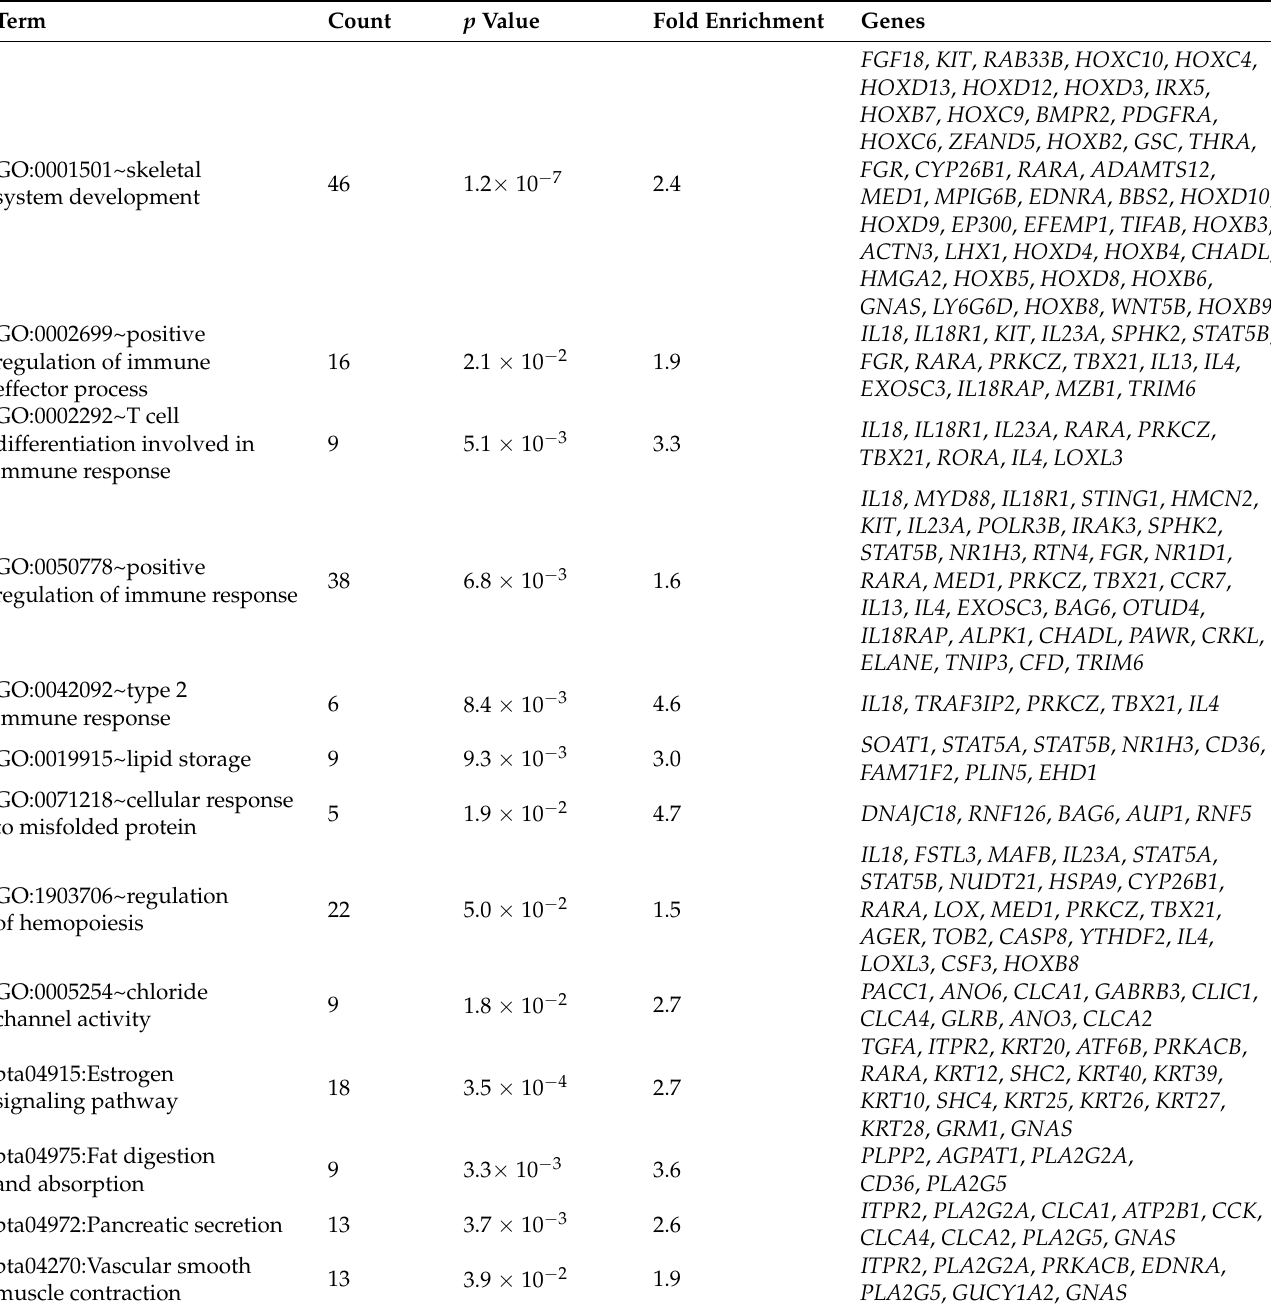
Table 5. GO cluster annotation of candidate genes commonly detected by the Hp , F ST , iHS , and XP-CLR scan